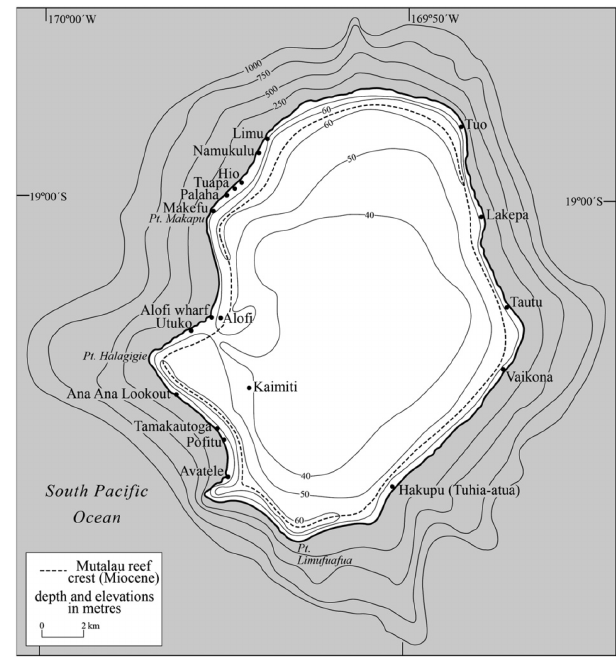
Figure 21. Bathymetric and topographic map of Niue (from Kennedy et al.,